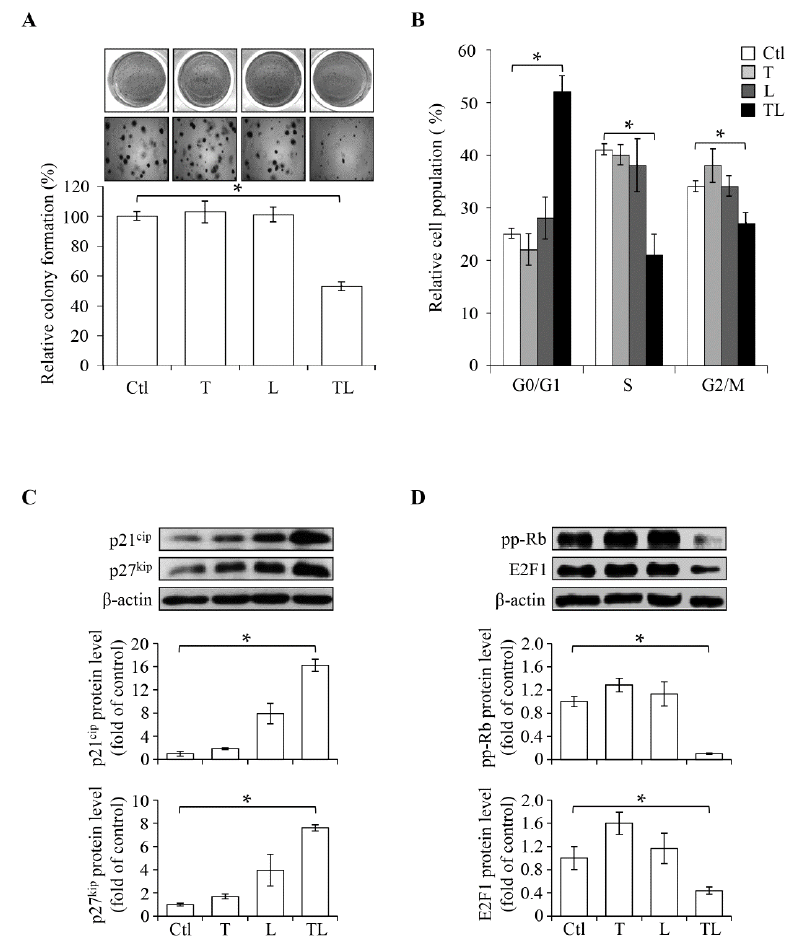
Figure 3. Combination treatment of troglitazone and lovastatin inhibits cell cycle progression. ( A ) Combination treatment of troglitazone (T) and lovastatin (L) restrained the anchorage-independent growth of SW1736 cells in semi-solid agar. Cells were treated with the indicated drugs for 14 days and then the relative cell colony formation was assayed. Cell colonies were fixed and then stained by crystal violet (magnification × 40). ( B ) The combination treatment increased the relative ratio of cell populations accumulating at the G0/G1 phase. Cells were treated with the indicated drugs for 24 h and then the DNA content was analyzed by flow-cytometry. ( C , D ) Combination treatment induced the protein expression levels of p21 cip and p27 kip ( C ) and inhibited the hyperphosphorylated (pp)-Rb and E2F1 ( D ). Upper panels: immunoblotting images. Lower panels: quantification of immunoblotting. Cells were treated with the indicated drugs for 24 h and analyzed by immunoblotting. Values represent the means ± S.E.M. ( n = 3). * p < 0.05. Ctl: control; L: lovastatin; (2 µ M) T: troglitazone (10 µ